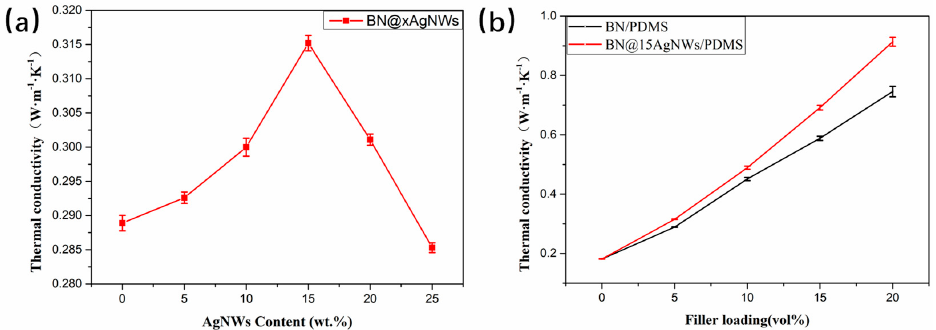
Figure 5. ( a ) Thermal conductivity of polydimethylsiloxane (PDMS) with 5 vol% BN@xAgNWs hybrid fillers and ( b ) ther- mal conductivity of BN@15AgNWs PDMS with different filler